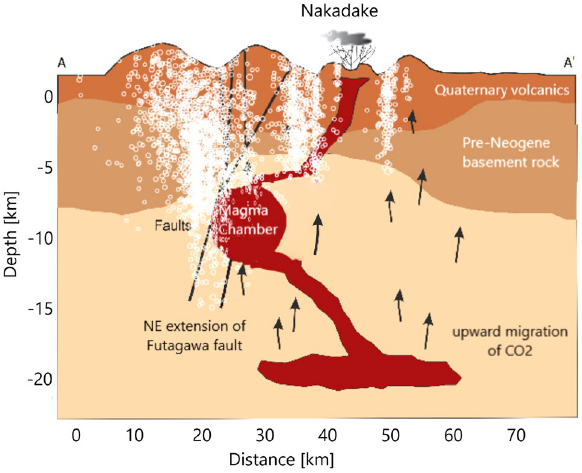
Figure 2. Conceptual model for the study area along profile A–A ′ (Fig. 1) based on previous geophysical investigation. The aftershocks of the 2016 earthquake sequence with M w > 2.5 (white) is superposed to the conceptual